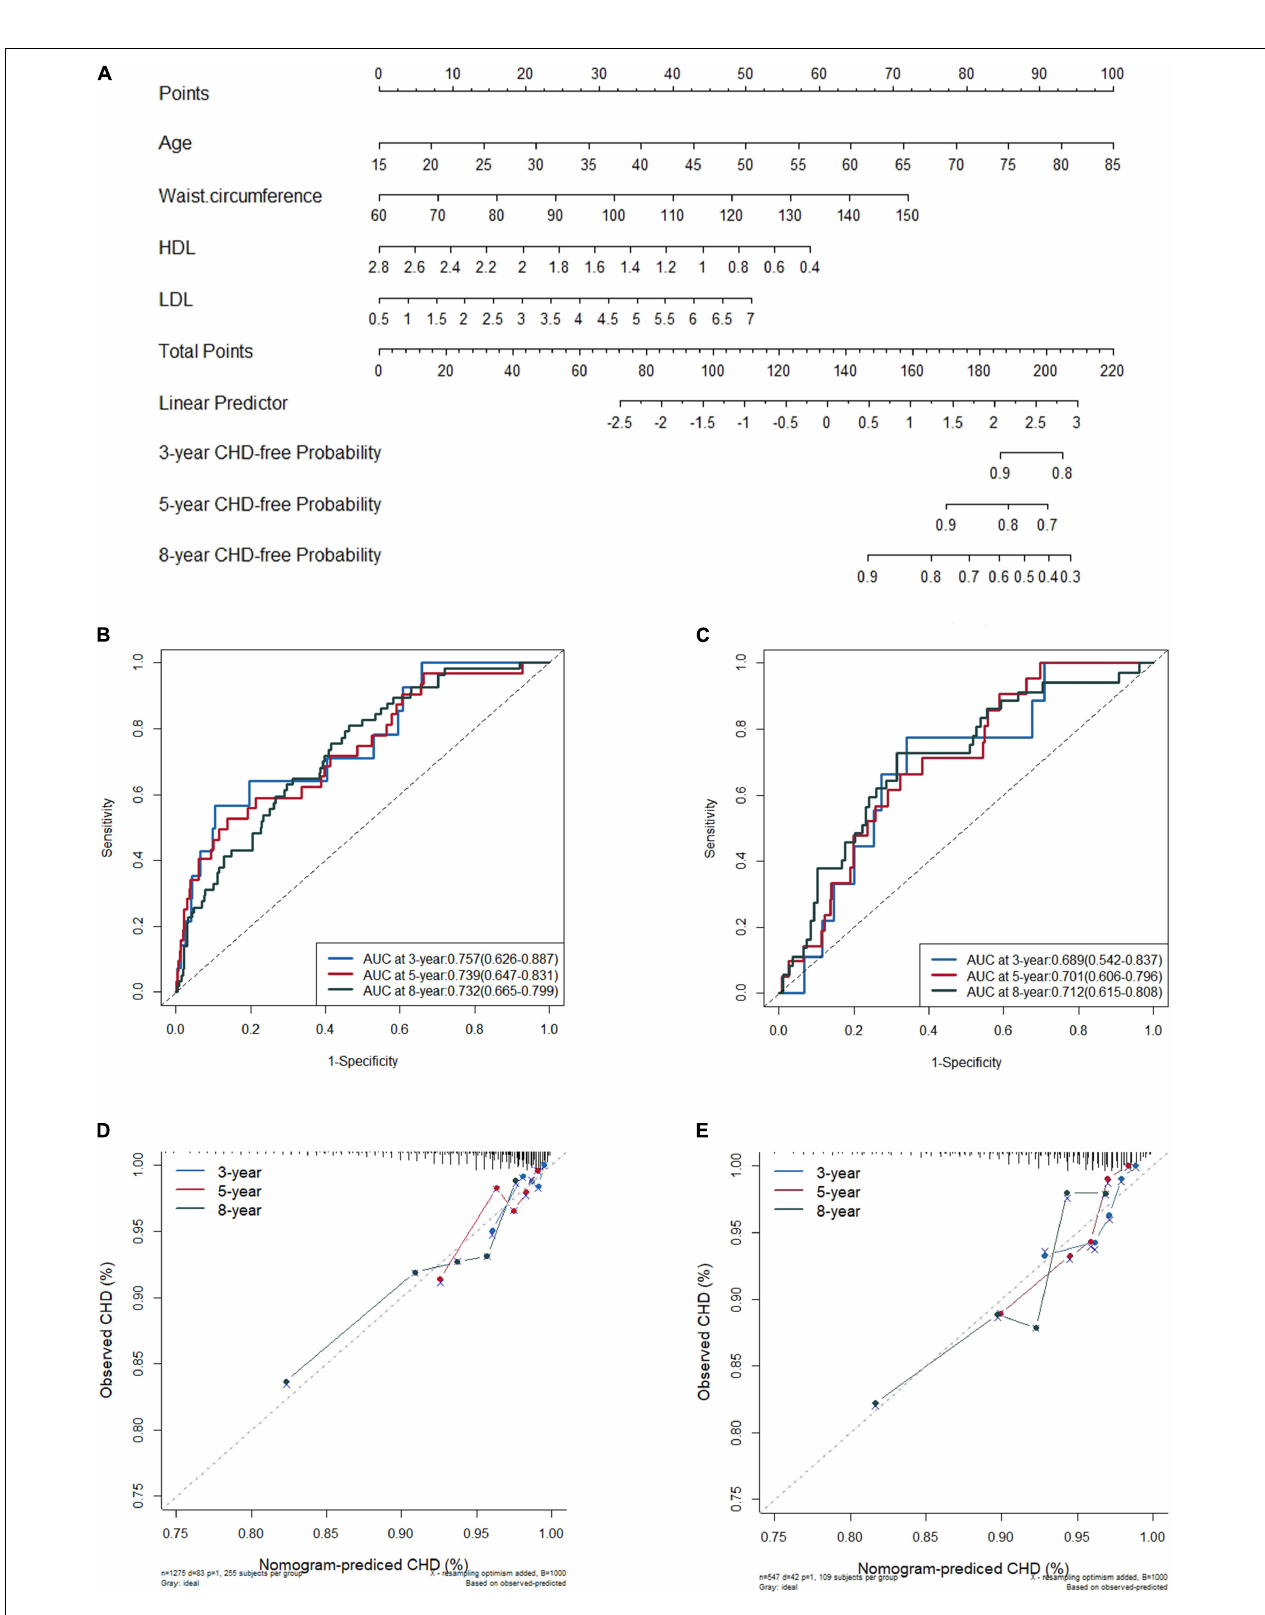
FIGURE 2 | Nomogram for predicting new onset coronary heart disease (CHD) in the training set (A) , the receiver operating characteristic (ROC) curves of the model in training set (B) and in validation set (C) , and the calibration plots in the training set (D) and in the validation set (E) at 3, 5, and 8 years.